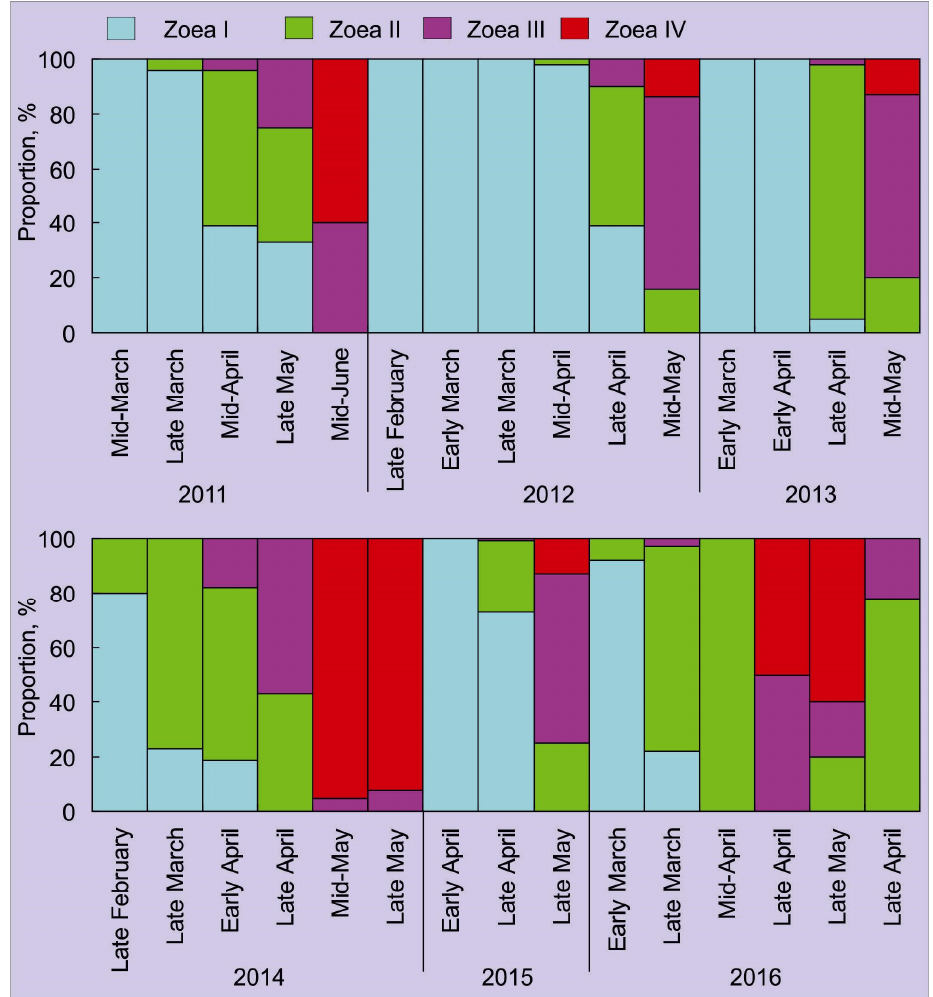
Figure 7. Stage structure of red king crab larvae in Russian waters of the Barents Sea (2011–2016, Ura Bay) (modified from [81,84]). Table 2. Total abundance (individuals m –2 ) of red king crab larvae in the plankton in Ura Bay in 2011–2016 (adapted from [81]).